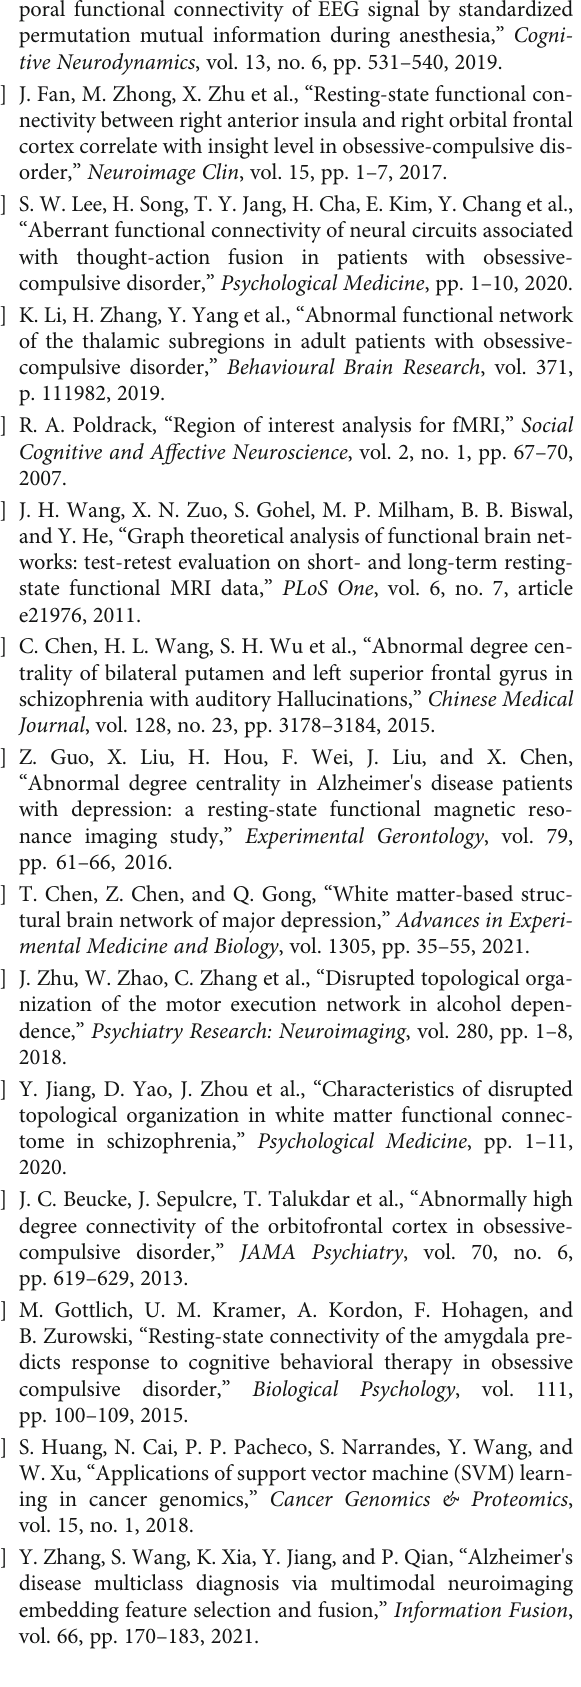
Table S1: abnormal degree values in the patients with OCD (GSR removed). Figure S1: abnormal degree values in the patients with OCD (GSR removed). t values from two- sample t -tests with p < 0 : 05 (GRF corrected). Red denotes increased degree values; blue denotes decreased degree values. OCD =obsessive-compulsive disorder; GSR= global signal regression; L=left; R=right. (Supplementary